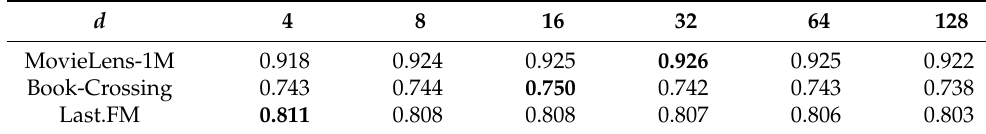
Table 4. Results of AUC on three datasets with different embedding dimensions.